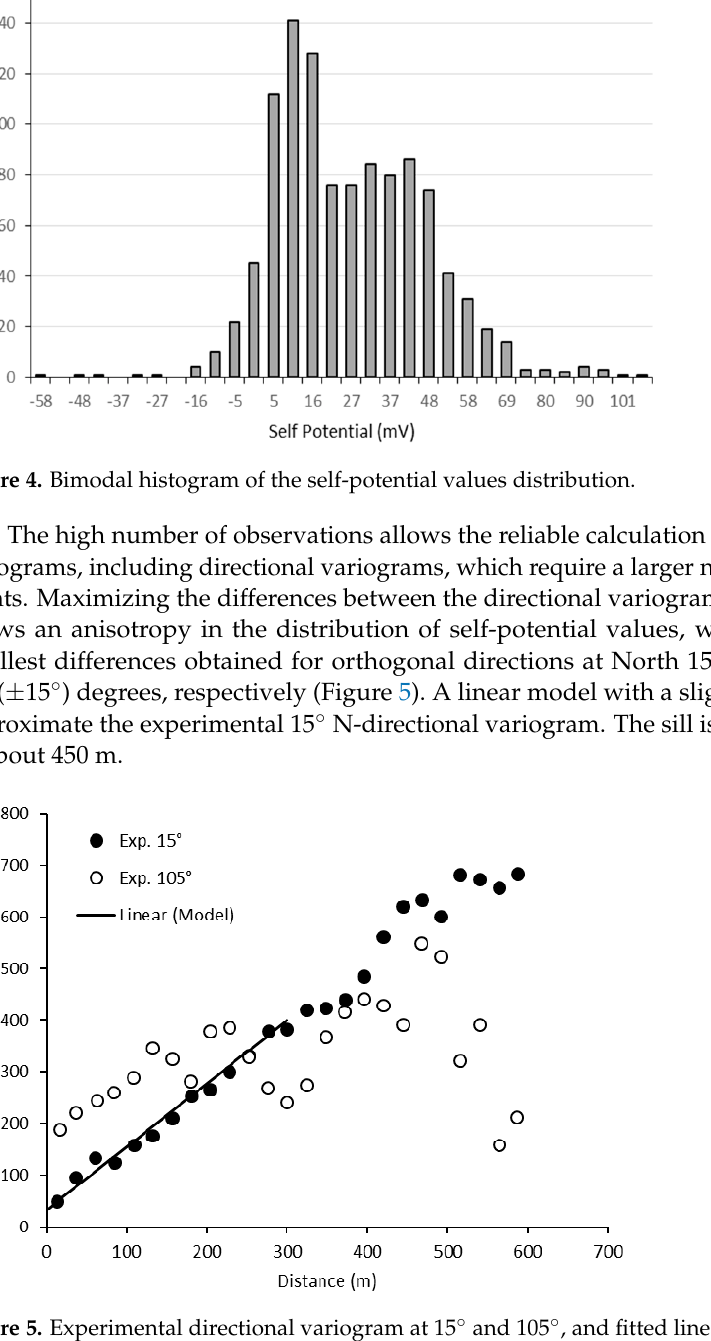
Figure 5. Experimental directional variogram at 15° and 105°, and fitted linear model.